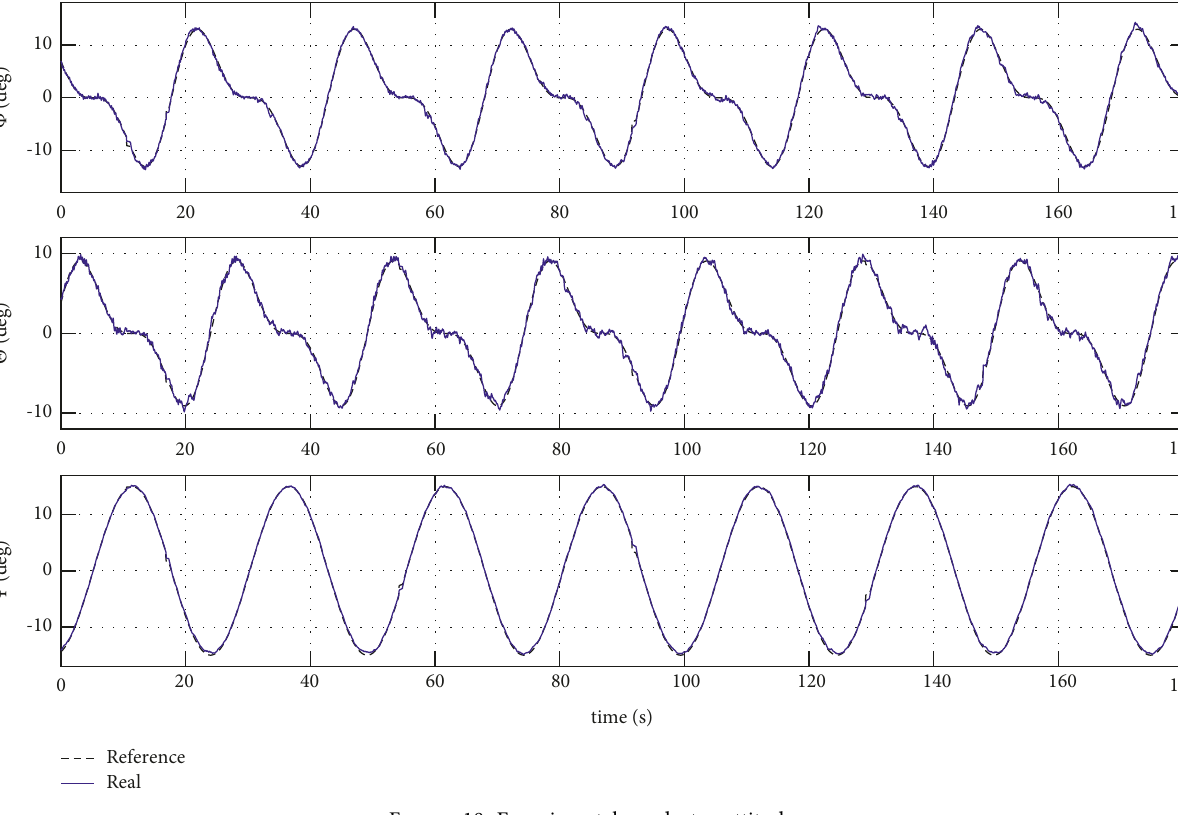
Figure 18: Experimental quadrotor attitude.